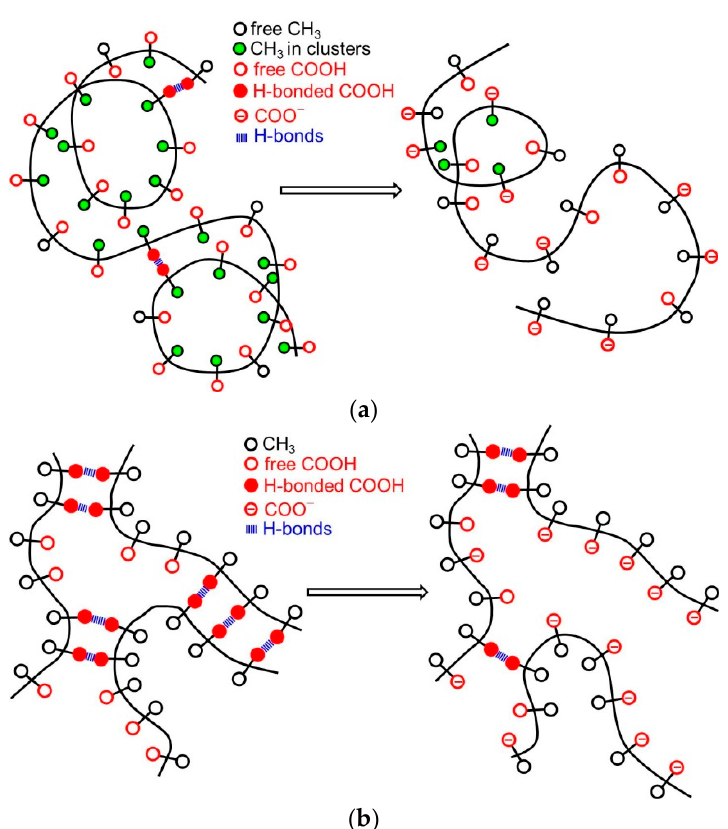
Figure 9. A schematic representation on the molecular level of the unfolding of the ( a ) aPMA and ( b ) iPMA chains caused by ionization of carboxyl groups or by dilution of solutions. Note that in the case of ionization, carboxyl groups attain a negative charge (which is indicated in the Figure) whereas upon dilution these groups remain uncharged or retain the same charge as in the initial state.